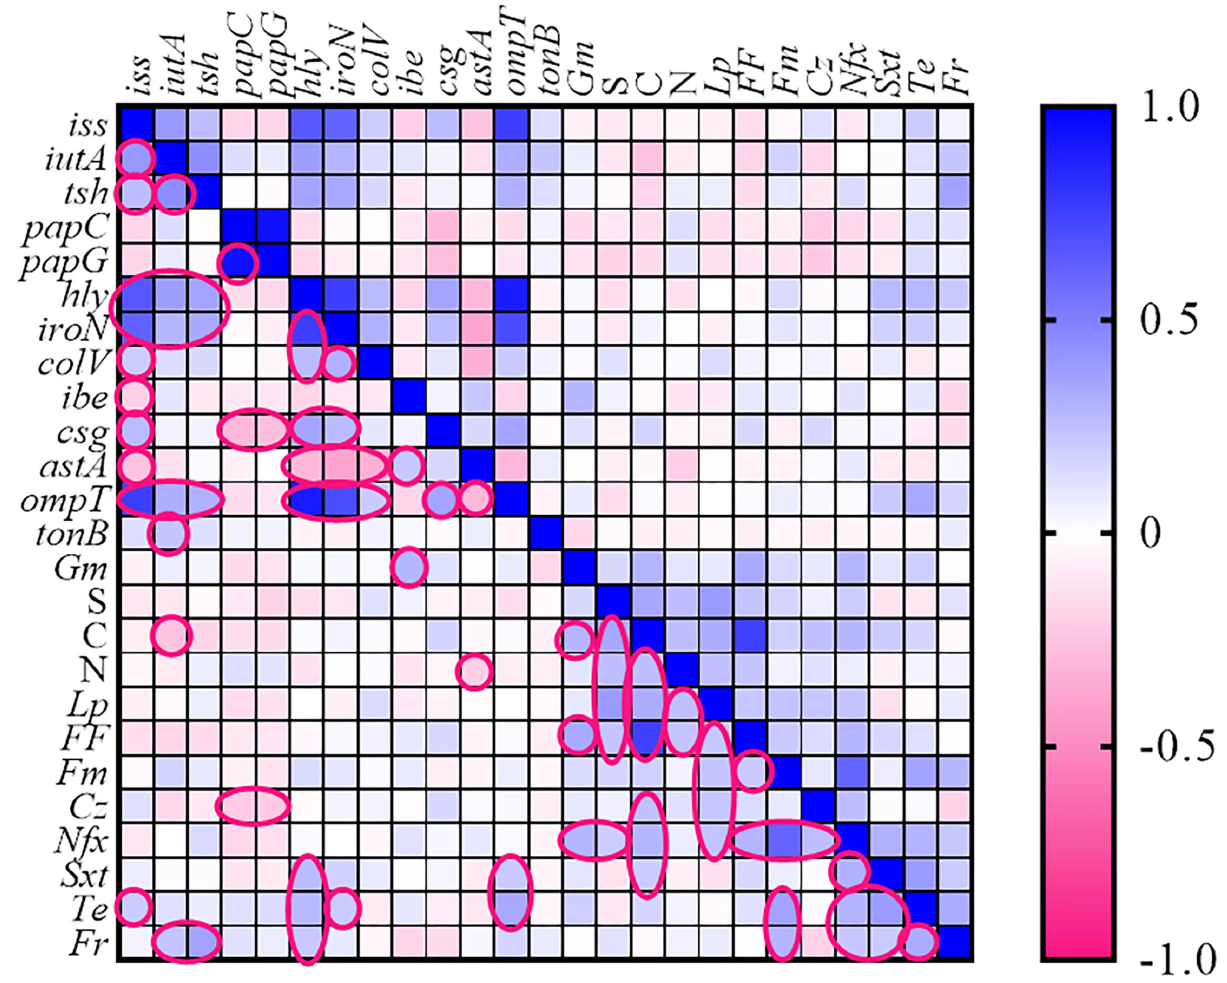
FIGURE 2 | Heatmap generated according to association between genotype and phenotype traits of Escherichia coli strains. The statistically significant associations ( p < 0.05) between traits are indicated in the closed pink line. No values were introduced in the cases of resistance to fosfomycin, ceftriaxone, and cefixime. Gm, gentamycin; S, streptomycin; N, neomycin; Lp, lincospectin; Fm, flumequine; Cr, chloramphenicol; Nfx, enrofloxacin; Sxt, sulfamethoxazole-trimethoprim; Te, tetracycline; Fr,